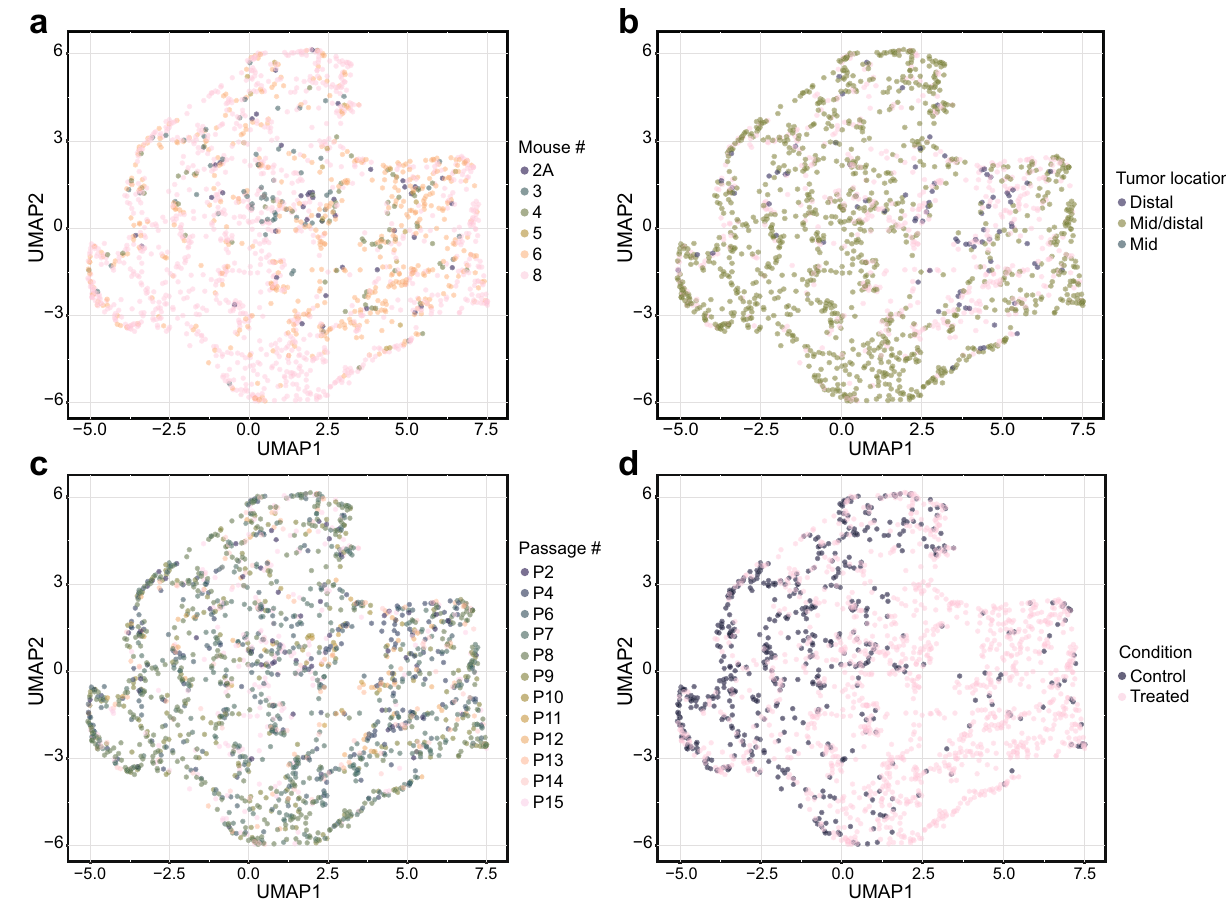
Figure 5. Multivariate analysis validates the finding that most baseline culture conditions do not affect growth or drug response. UMAP data-reduction examined four key variables (baseline diameter, distance to the edge of the Matrigel droplet, day 2 diameter, and percent change in diameter) to determine if baseline culture conditions caused clustering of individual MDCOs. UMAP visual representations showed that ( a ) MDCOs derived from different mice of the same genotype, ( b ) location of the original tumor within the colon, or ( c ) passage number did not cause clustering of MDCOs. Only ( d ) control and treated MDCOs showed any clear separation. (n = 1835